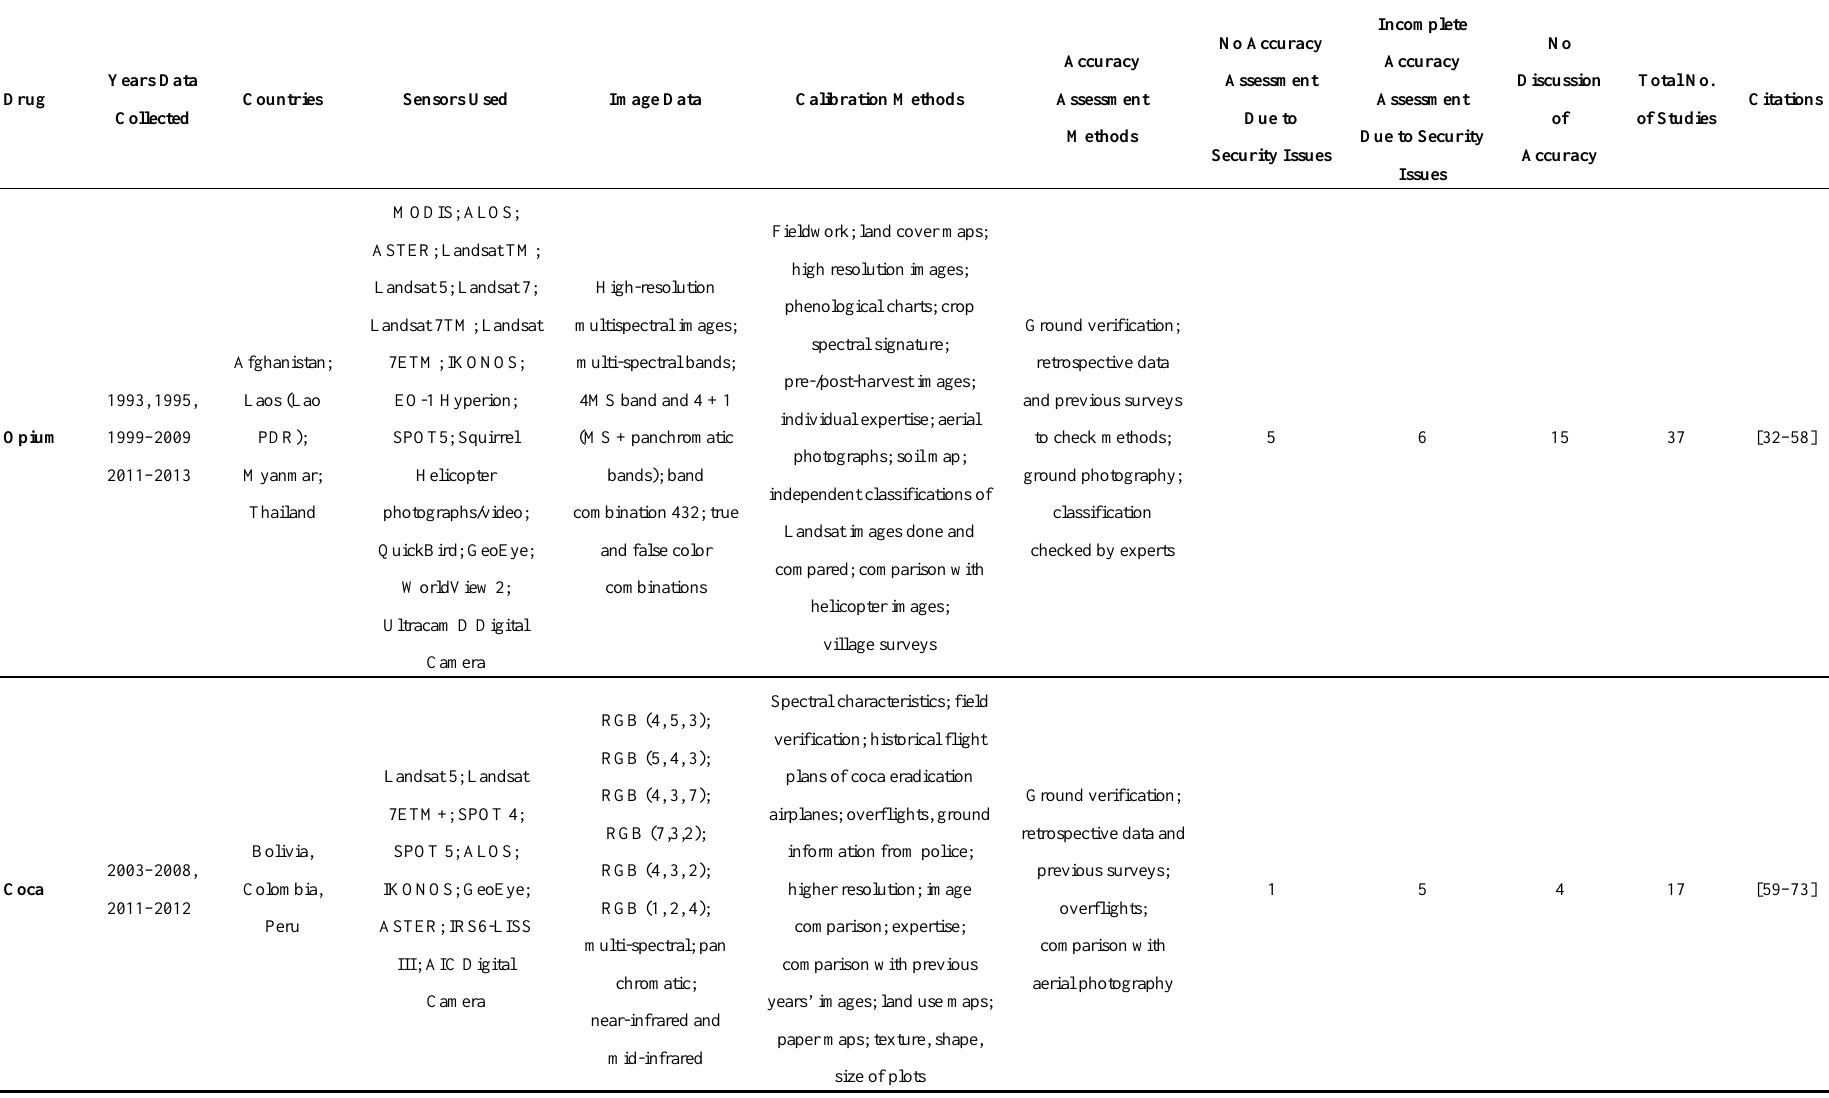
Table 1. Summary of available studies using remote sensing in the active reconnaissance of drug